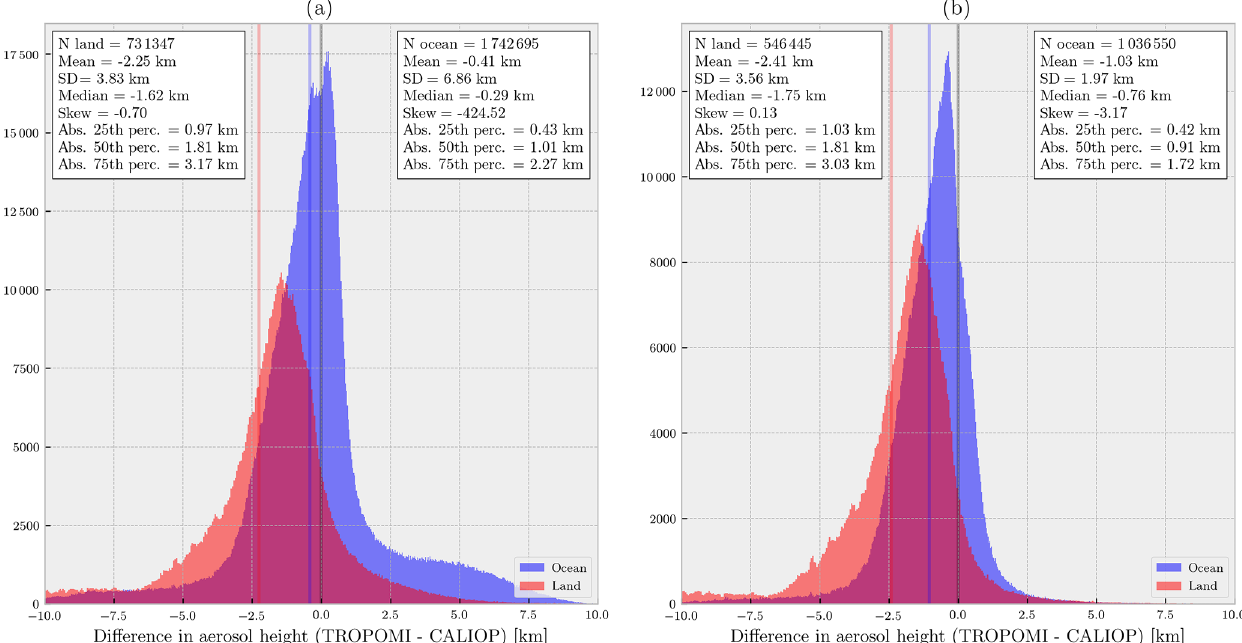
Figure 2. Histogram of differences between CALIOP ALH ext (Eq. 2) and TROPOMI ALH from co-located data between 1 May 2018 and 28 February 2019. Blue histogram represents TROPOMI pixels over the ocean, whereas the red histogram is for TROPOMI pixels over land. The blue line represents the mean difference between TROPOMI ALH and CALIOP ALH ext for TROPOMI pixels over the ocean, whereas the red line represents the same for TROPOMI pixels over land. The black line at 0.0km difference on the x axis is plotted to aid the reader in their interpretation of this figure. (a) All co-locations except TROPOMI pixels falling in the sun-glint region. TROPOMI pixels with retrieved AOT greater than 5.0 are discarded. For pixels over land, if the Global Ozone Monitoring Experiment-2 (GOME-2) surface albedo values are less than 0.1 or greater than 0.4, they are discarded. Similarly, over the ocean all TROPOMI pixels that have GOME-2 surface albedo values greater than 0.05 are discarded. (b) Same, except only TROPOMI ALH retrievals that are cloud screened using the cloud_warning flag from Table 1 are